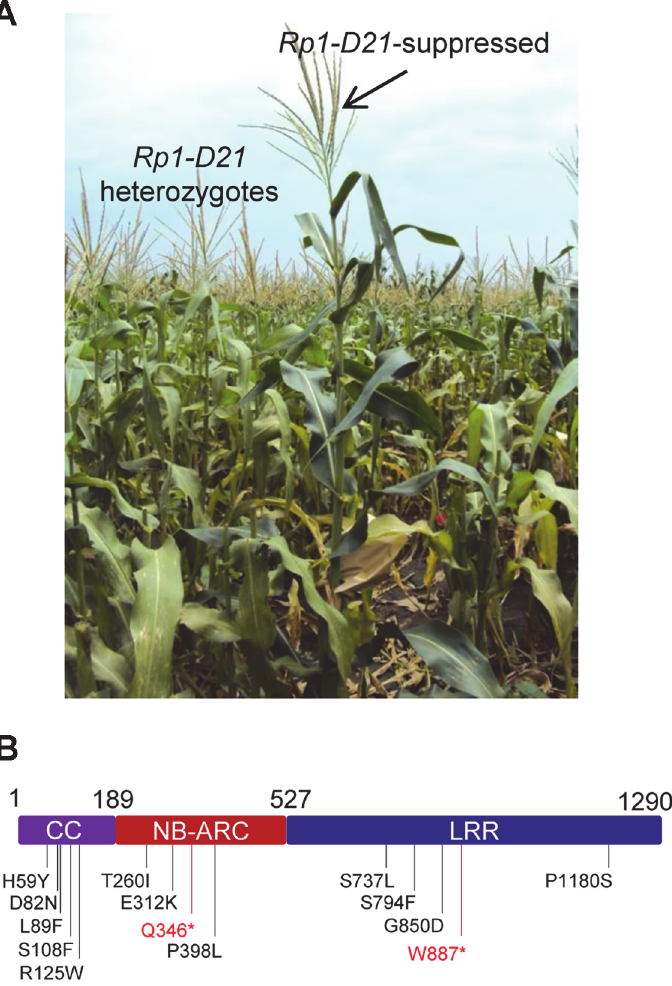
Fig 2. EMS mutagenesis screening for mutants that lost the hypersensitive response (HR) induced by Rp1-D21 . (A) The growth phenotype of Rp1-D21 heterozygotes in the field compared to the Rp1-D21 mutant in which the HR phenotype is suppressed (arrow). (B) Twelve missense (in black) and two nonsense (in red) point mutations that abolished the HR phenotype of Rp1-D21 were identified in different domains (CC, NB- ARC and LRR) of